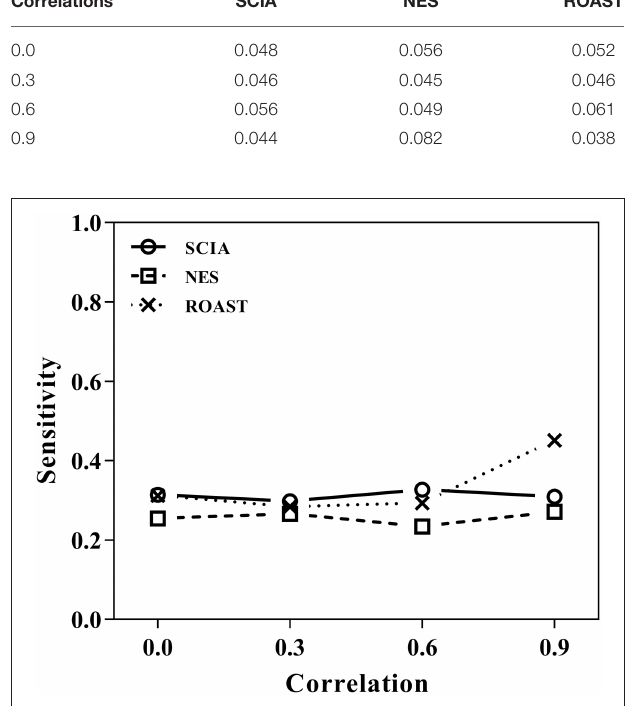
TABLE 2 | FDR is well-controlled by SCIA similar to other self-contained methods under different inter-gene correlations in simulated datasets.